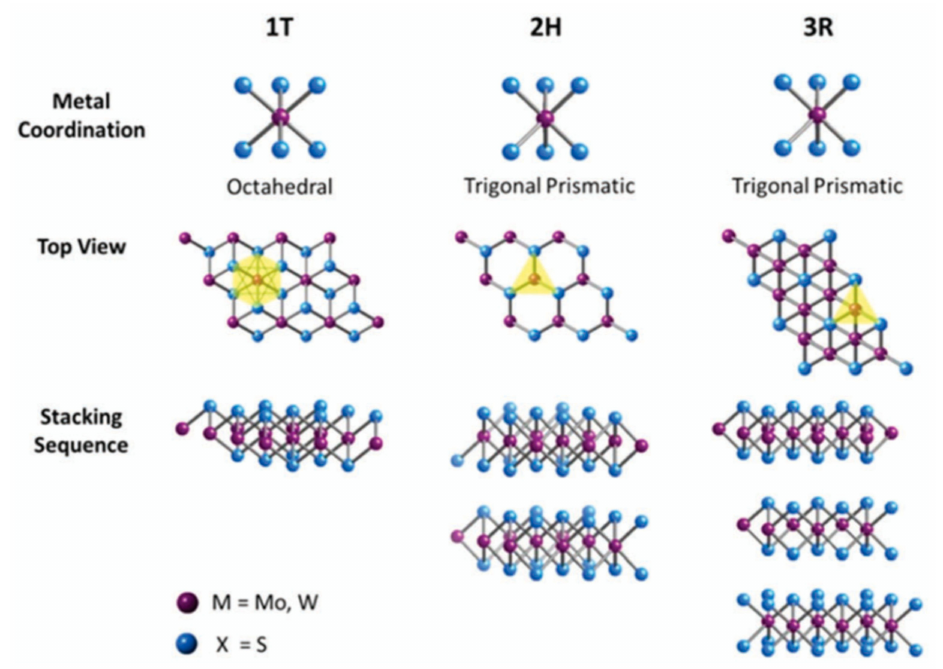
Figure 1. Metal coordination and stacking sequences of transition metal dichalcogenide (TMDC) structural unit cells. Metal coordination can be either octahedral or trigonal prismatic. The octahedral coordination allows stacking sequences which yield a tetragonal symmetry (1T). Dissimilar stacking sequences of trigonal prismatic single layers can give rise to di ff erent symmetries: hexagonal symmetry (2H) and rhombohedral symmetry (3R). Reproduced from R.J. Toh et al. Chem Commun., 2017,